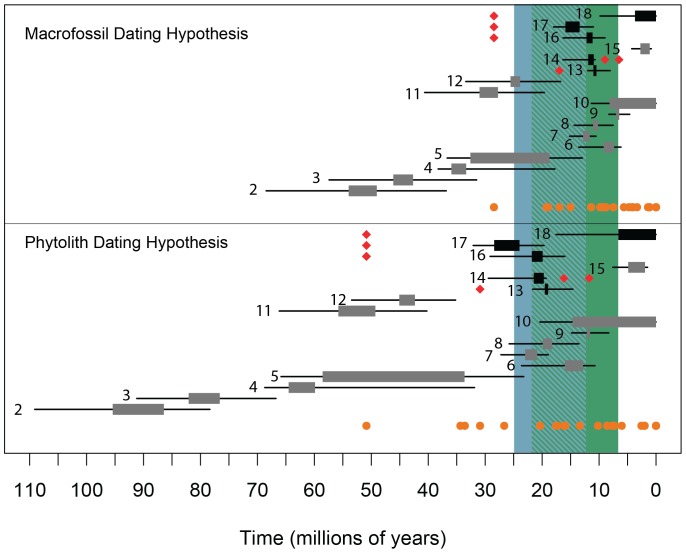
Timing of shifts in diversification rate across both dating hypotheses.Both grey and black rectangles indicate shifts in diversification rate bounded by the estimated stem and crown node ages for the branch where the shift occurred. Error bars are determined by the 95% confidence interval for each age estimate. Each shift is numbered are corresponds to the shifts in both Figure 3 and Table S5. The black rectangles indicate accelerations that occurred within C4 clades or immediately before C4 origins. Orange dots indicate the crown node ages for each of the estimated 24 origins of C4 photosynthesis in Poaceae. The red diamonds are the origins that are associated with subsequent rate shifts. The blue area indicates the time when grasslands are estimated to have arisen on various continents [55]–[62], [2], [63], and the green area is the time when C3 grasslands were replaced by C4 grasses [65]–[70], [2]. Overlap between the two is indicated by diagonal hatches.